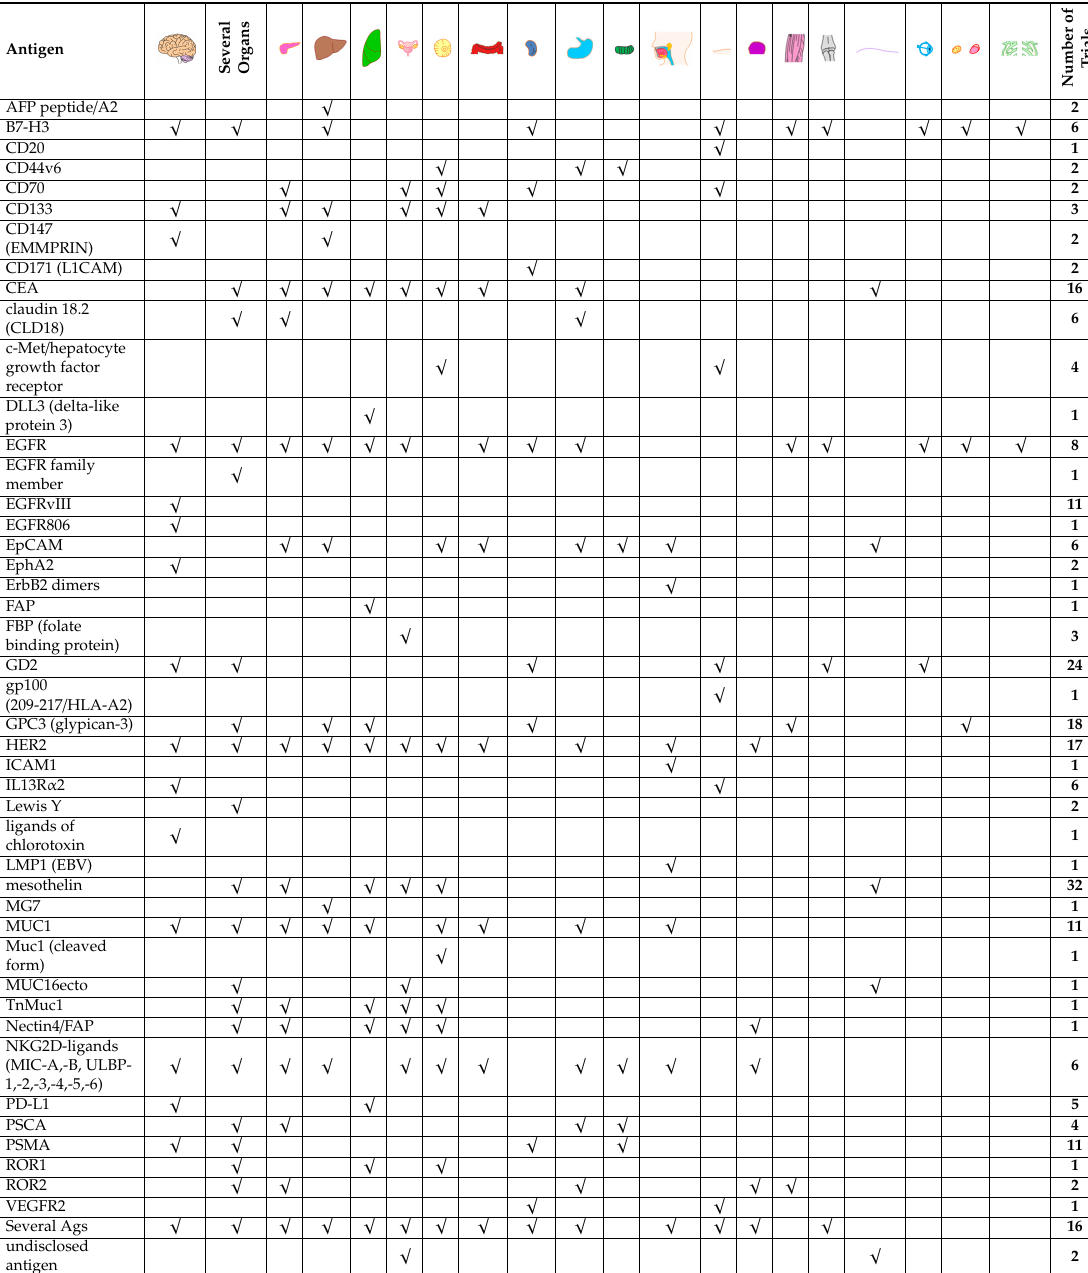
Table 1. Summary of antigens expressed by solid tumors in di ff erent organs targeted by. CAR-T cells in trials registered at